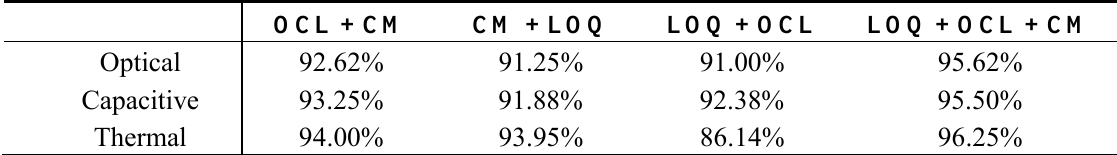
Table 5. Comparison of the classification accuracy rate when combined quality measures are used.